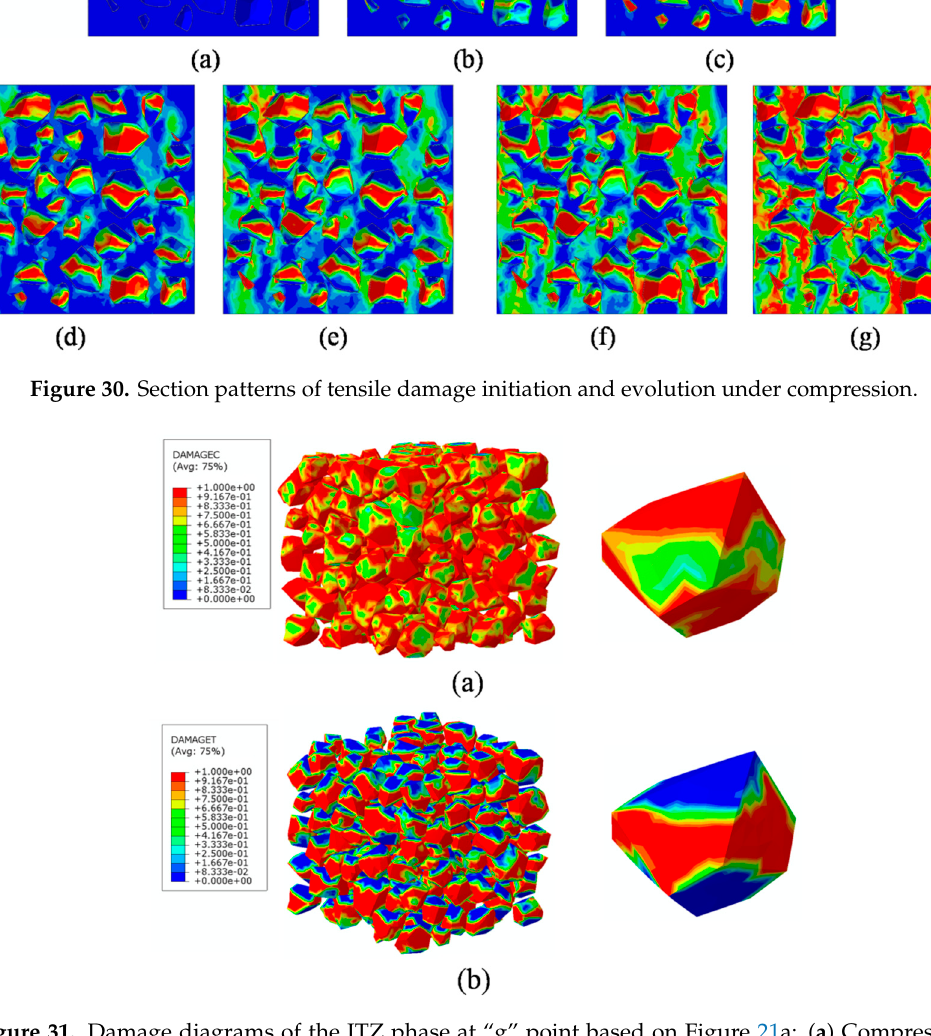
Figure 31. Damage diagrams of the ITZ phase at “g” point based on Figure 21a: ( a ) Compressive damage, ( b ) tensile damage.